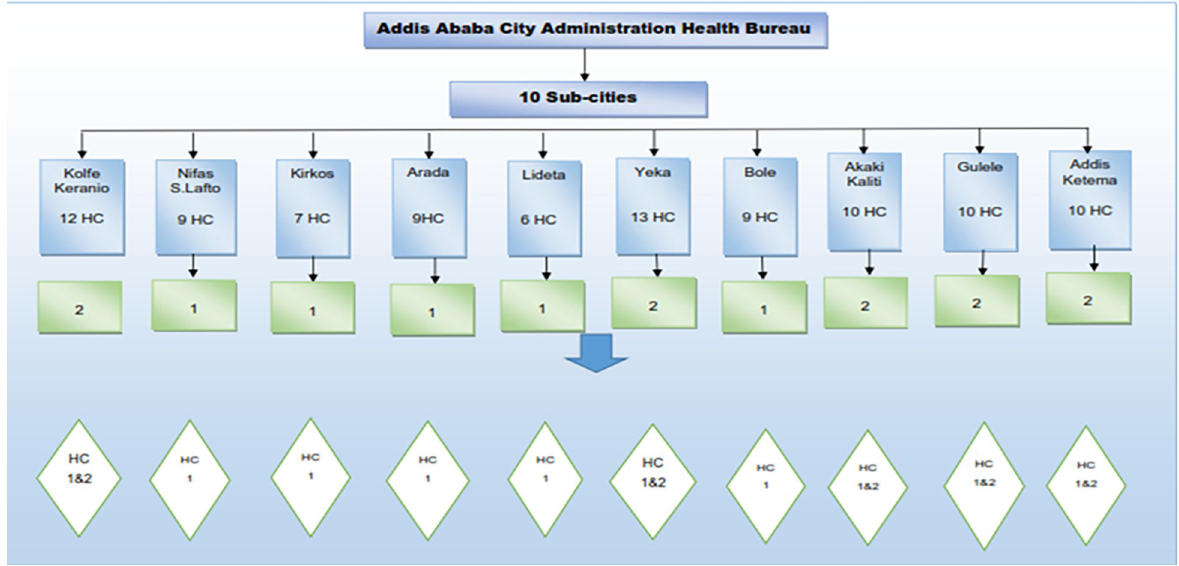
Fig 1. Number of health centres selected from ten sub-cities of Addis Ababa City Administration, February 2018.